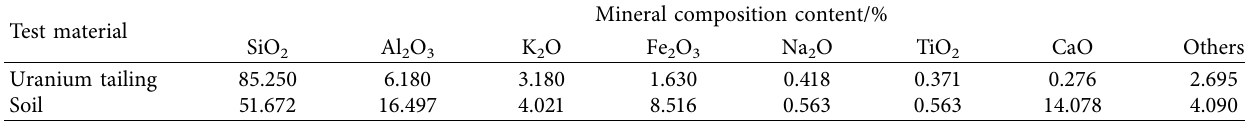
Table 1: Main mineral compositions of test materials.